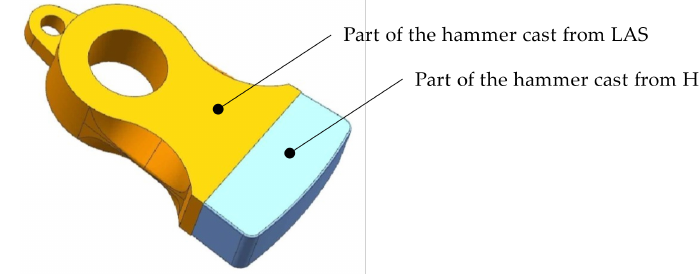
Figure 1. A simulated LAS/HCCI bimetallic hammerhead.